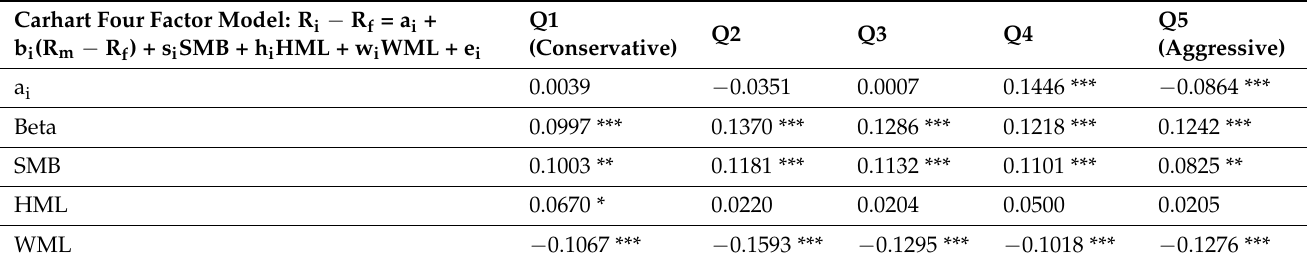
Table 10. Robustness check for Conservative and Aggressive Investment REIT portfolios (2001–2020).